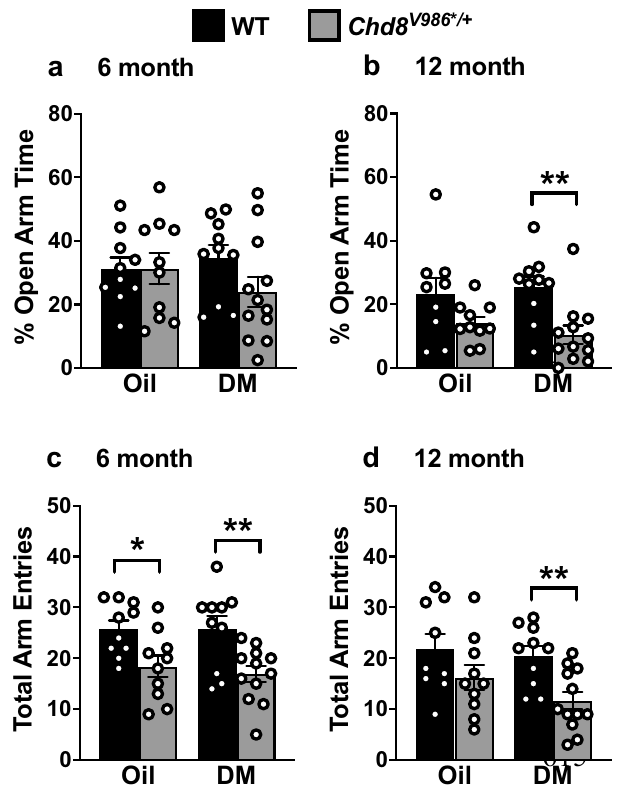
Figure 2. Increased anxiety-like behavior in Chd8 V986*/ + mice following DM exposure. (a,b) Time spent in the open arms and (c,d) number of total arm entries in the elevated plus maze were assessed. Data are means (± SEM) for a 5 min test in an elevated plus maze. N = 10–12 mice per group. Fisher’s PLSD tests were used for comparing group means only when a significant F value was determined by using a two-way ANOVA, with genotype and treatment as factors. *p < 0.05; **p <